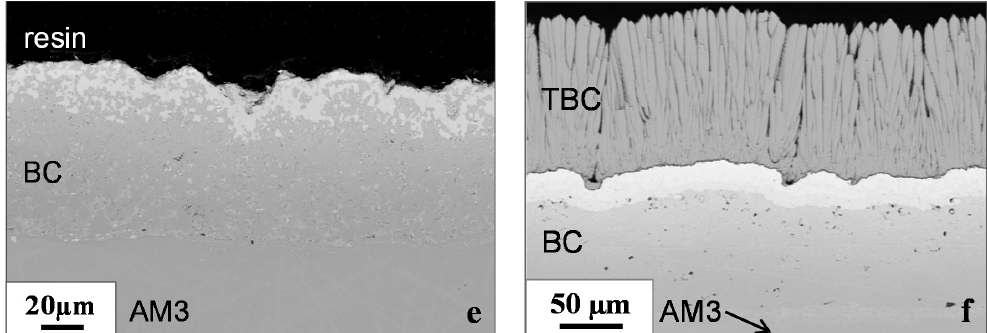
Figure 1. ( a , b ) As-processed surface of the Trib-Pt/2 coating on AM3 after heat treatment under vacuum. Cross-sections of as-processed; ( c ) Trib-Pt/2 coating; and ( d ) corresponding thermal barrier coating (TBC) system on AM3; ( e ) Cross-sections of as-processed Trib-Pt/1 coating on AM3; ( f ) Cross-section of AM3-VPS-Pt TBC system. SEM images in BSE mode.